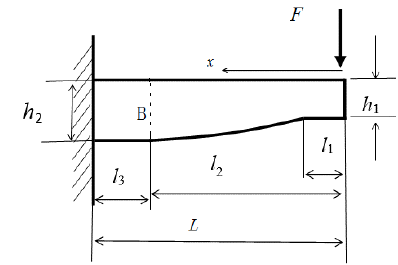
Figure 2. The mechanical model of the single taper-leaf spring.